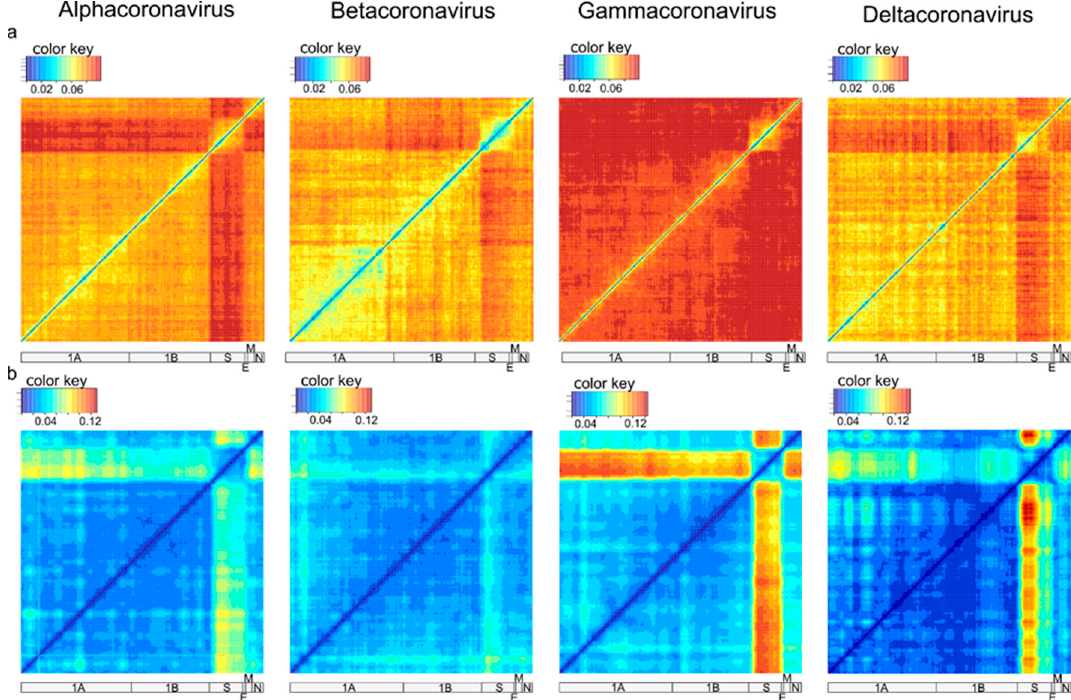
Figure 3. Recombination incidence in coronavirus genome detected by phylogenetic compatibility matrices based on normalized Robinson-Foulds distances ( a ) and pairwise distance deviation matrices (PDDM) based on deviations of points in PDCPs ( b ) for four Coronavirus genera. Spike gene is visually more involved in recombination relative to the rest of the genome in the four CoV genera. Colors reflect the values of normalized Robinson-Foulds distances and RMSE in PDCPs, respectively.